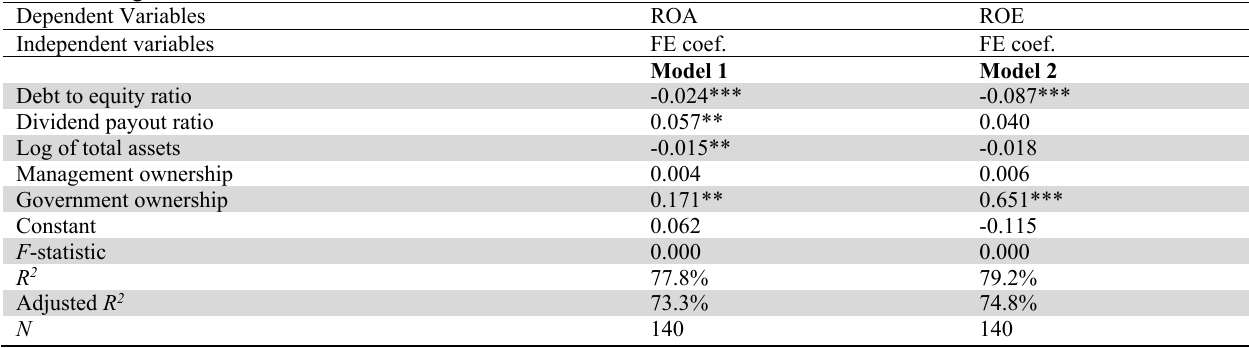
Panel data regressions Dependent